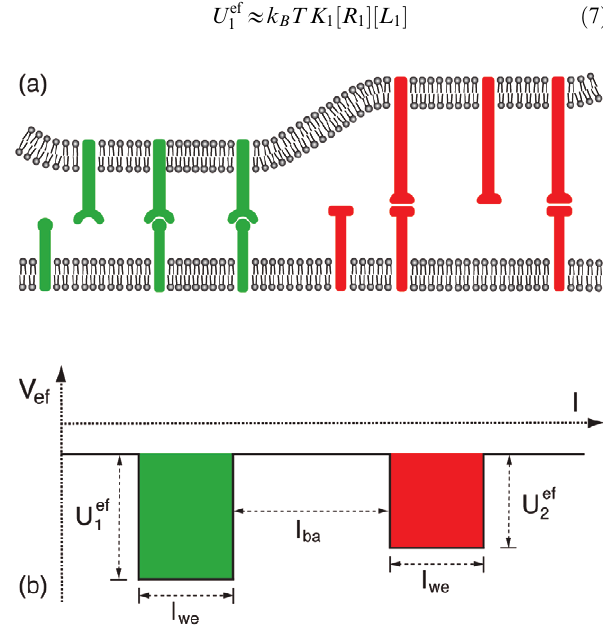
Figure 1. Effective adhesion potential. (a) Two membranes interacting via long (red) and short (green) receptor-ligand complexes. The length mismatch of the complexes causes membrane deforma- tions, which cost bending energy and lead to a membrane-mediated repulsion between different receptor-ligand complexes. - (b) The attractive interactions between the two types of receptors and ligands lead to an effective double-well adhesion potential V ef of the membranes. The potential well 1 at small membrane separations l reflects the interactions of the short receptor-ligand complexes, and the potential well 2 at larger membrane separations the interactions of the and U ef of the two long receptor-ligand complexes. The depths U ef 1 2 potential wells depend both on the concentrations and on the binding energies of the two types of receptors and ligands, see eqs. (7) and (8).